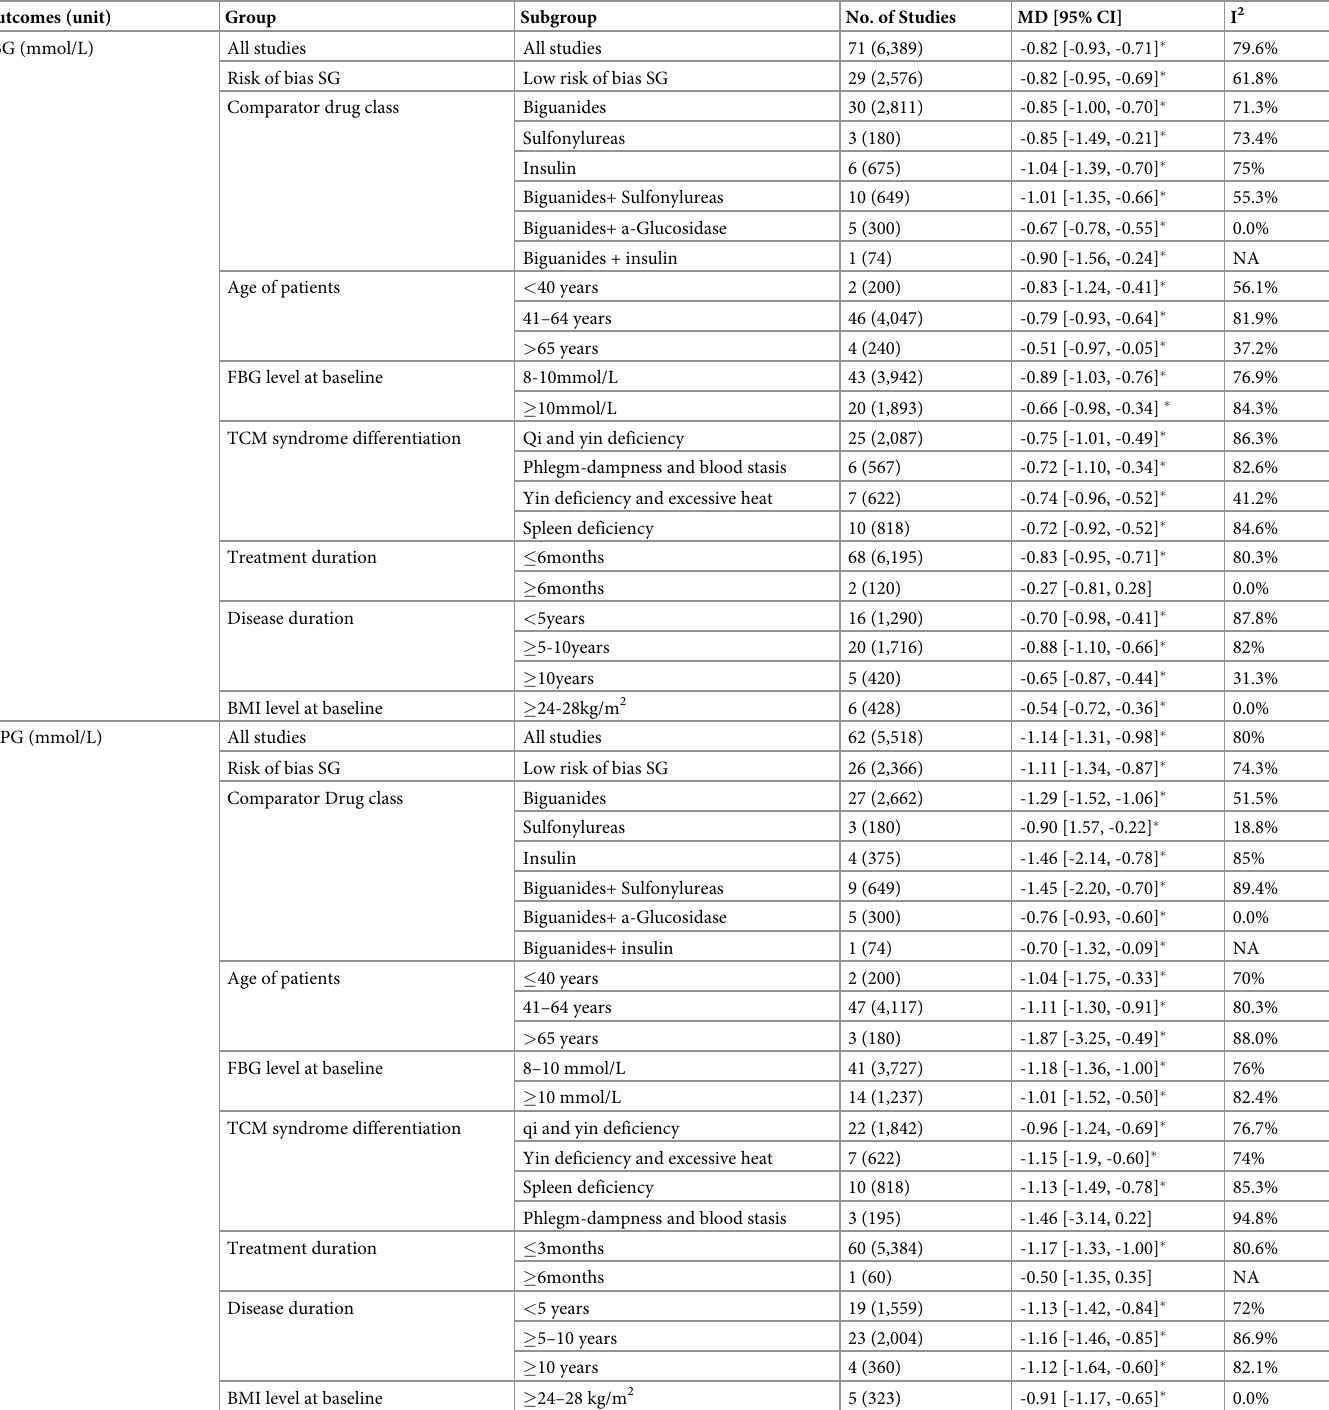
Table 3. Summary of meta-analysis results and sub-group analysis. Outcomes